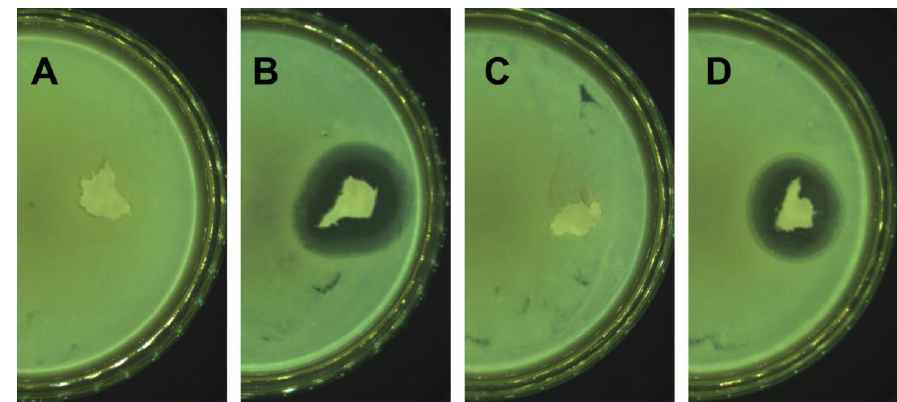
Figure 3. Examples of inhibition zones (against E. coli ) for ( A ) PM PLA/PVA-CH, ( B ) PM PLA/PVA-